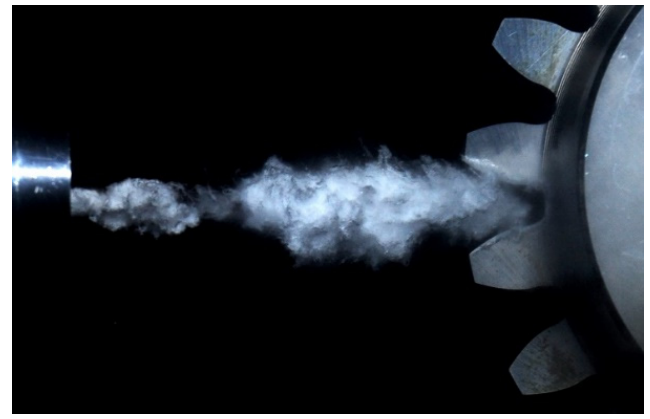
Figure 21. Aspect of cavitating jet injecting to the gear.